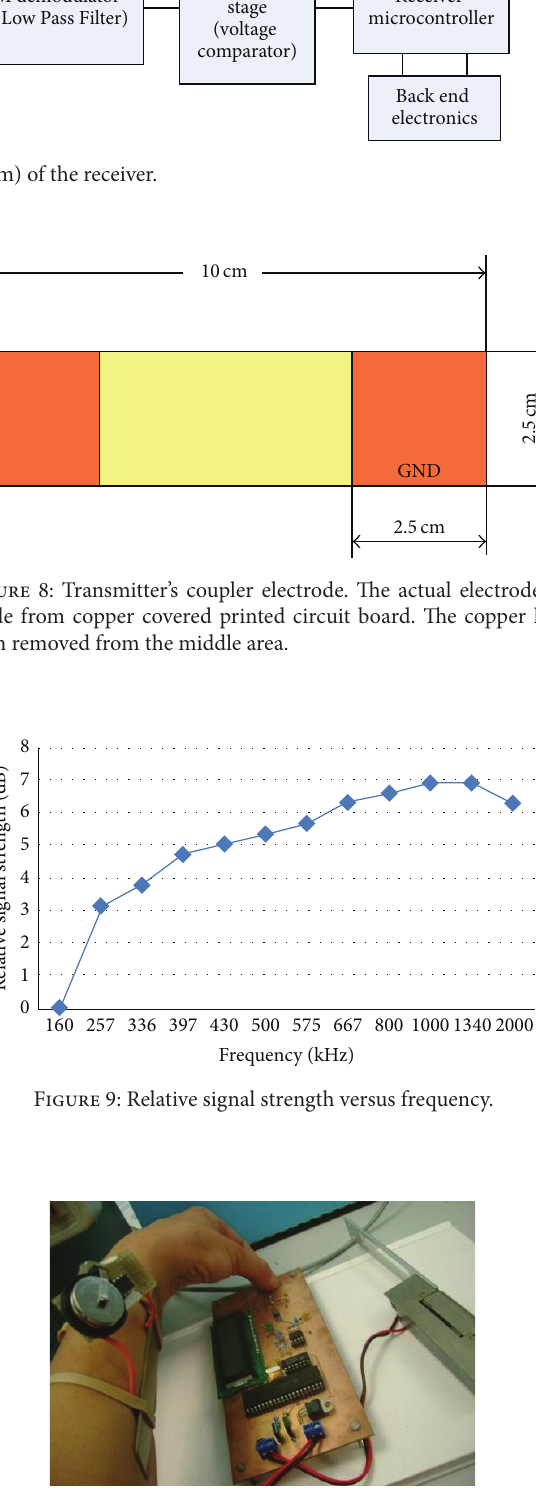
Figure 10: Human hand wearing the transmitter and touching the receiver board. At the right side, for demonstration purposes, is shown an electrically operated door